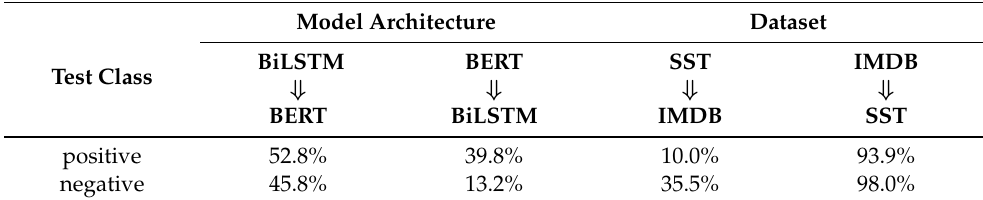
Table 4. Attack transferability results. We report the attack success rate change of the transfer attack from the source model to the target model, where we generate attack triggers from the source model and test their effectiveness on the target model. Higher attack success rate reflects higher